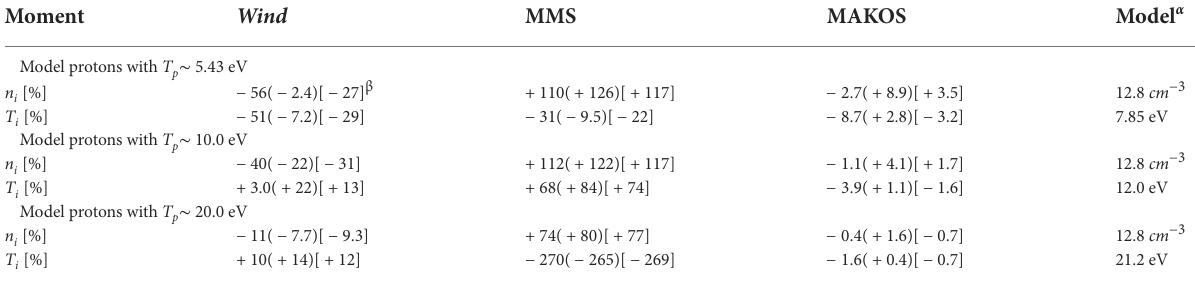
TABLE 3 Ionvelocitymomentaccuracy. Moment Wind MMS MAKOS Model α Model protons with T p ∼ 5.43 eV